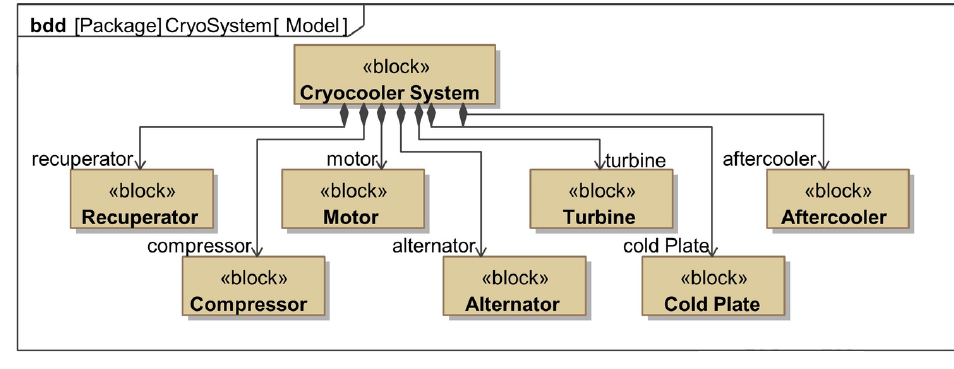
Figure 13. Cryocooler System BDD.